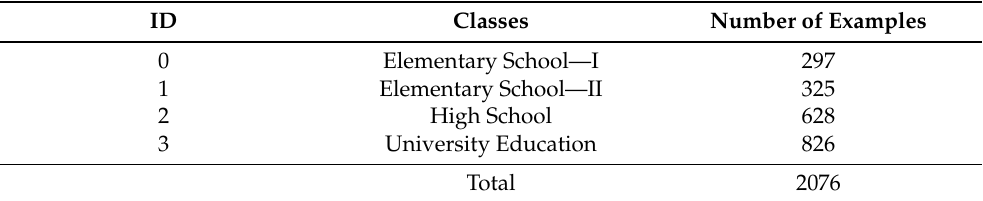
Table 7. Textual Complexity Corpus for School Internships in the Brazilian Educational System